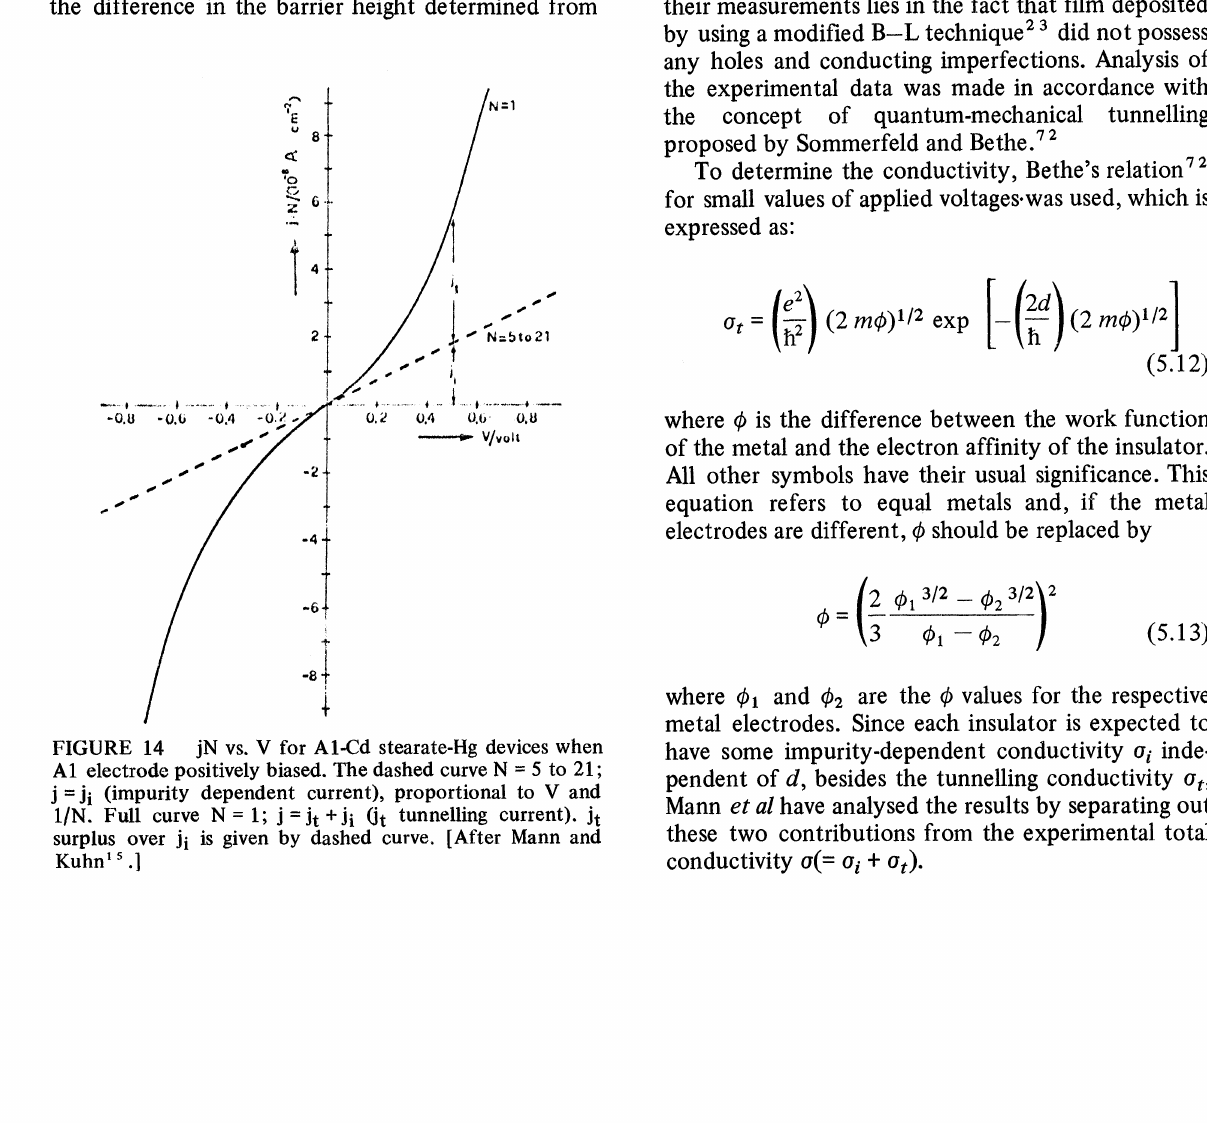
FIGURE 14 jN vs. V for A1-Cd stearate-Hg devices when A1 electrode positively biased. The dashed curve N 5 to 21; Ji (impurity dependent current), proportional to V and 1/N. Full curve N 1; =it +Ji (it tunnelling current). Jt surplus over Ji is given by dashed curve. [After Mann and Kuhn